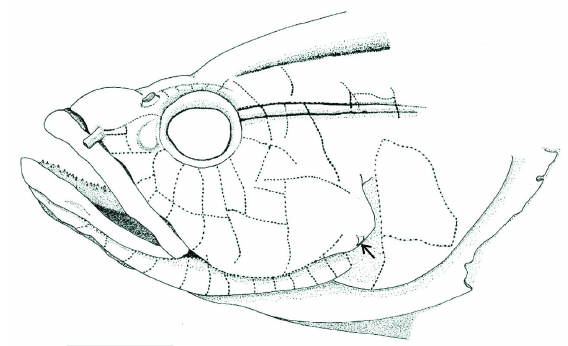
Figure 1. Eleotris melanosoma, WHT 5330, lateral view of head showing sensory papillae and spine on preopercle angle (arrow indicates the spine). Scale =